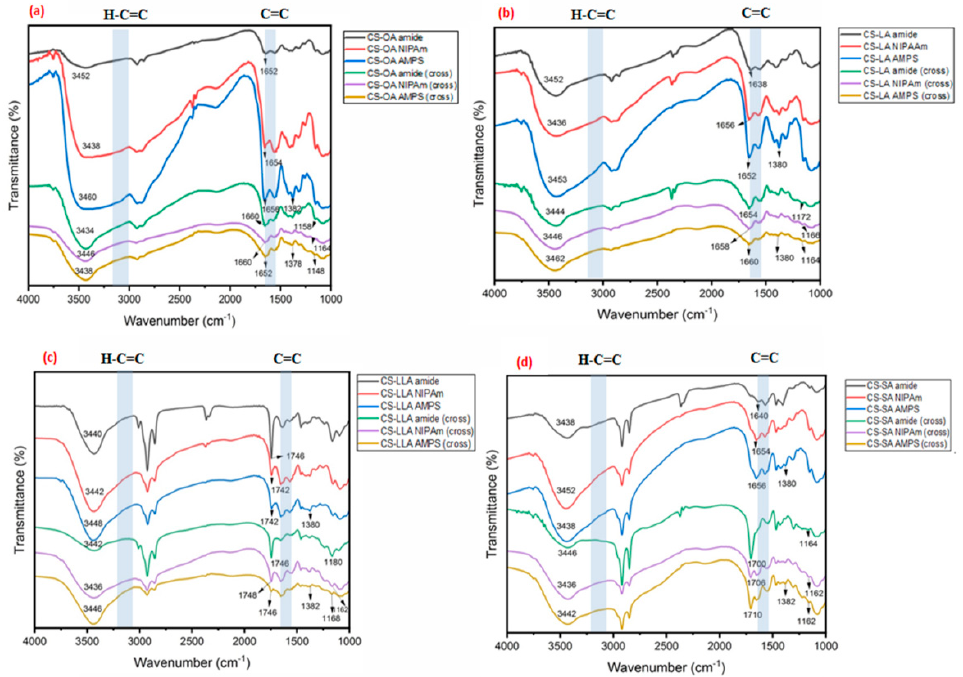
Figure 1. FTIR analysis of CS-amide, CS-amide-modified NIPAm or AMPS matrices before and after crosslinking; ( a ) OA; ( b ) LA; ( c ) LLA; and ( d ) SA.